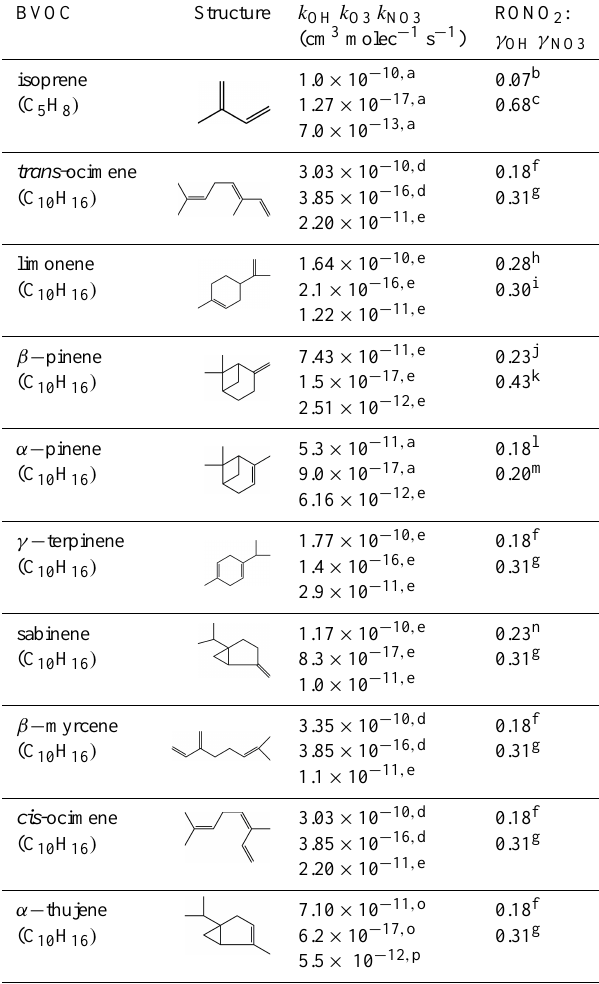
Table 1. BVOCs identified during branch-enclosure emission mea- surements for UMBS tree species. Corresponding reaction rate con- stants (units of cm 3 molec − 1 s − 1 ) for OH, O 3 , and NO 3 at 298 K ( k OH , k O3 , and k NO3 , respectively) and RONO 2 yields for reactions with OH and NO 3 ( γ OH and γ NO3 , respectively) are included for each BVOC identified. Individual BVOCs are displayed in order of simulated RONO 2 contribution; BVOCs contributing < 0 . 5ppt RONO 2 (at ∼ 12m above forest canopy) are shown in Table